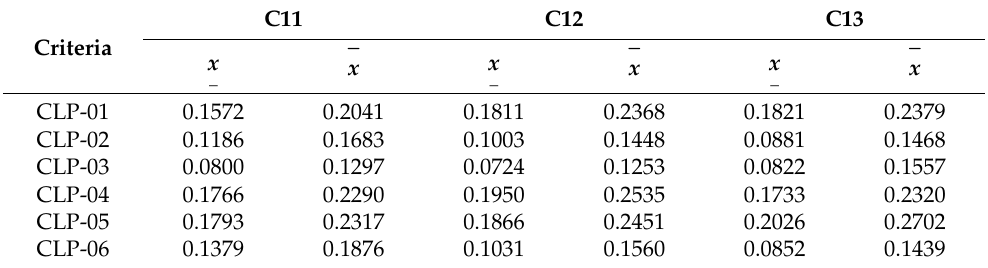
Table 12. The normalized grey decision matrix of C1 (environmental).